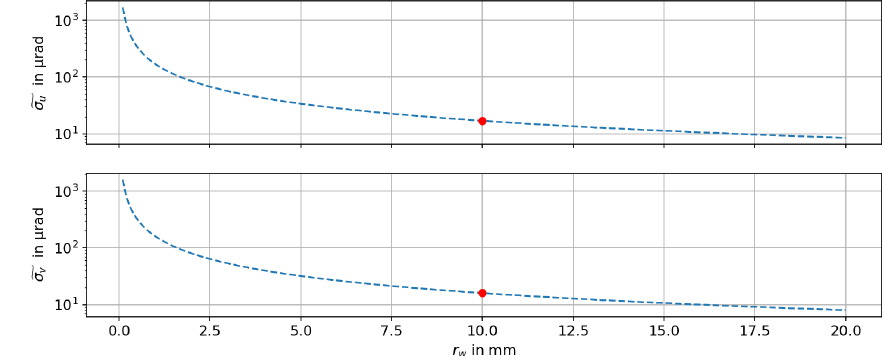
Figure 6. Determined ray direction uncertainty over the distance r w between the two detection planes. The markers indicate the values considered for the further estimation of the influence on the results of the measurement